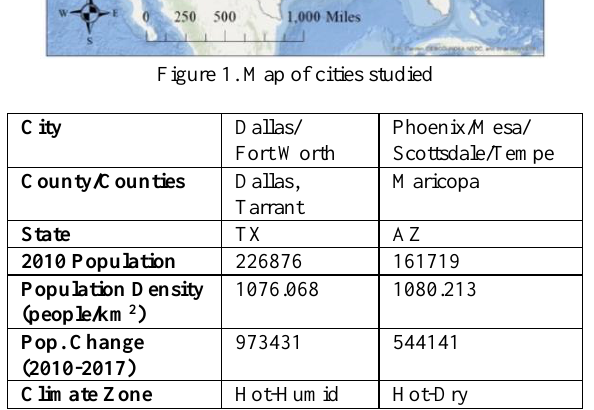
Table 1. Cities in study